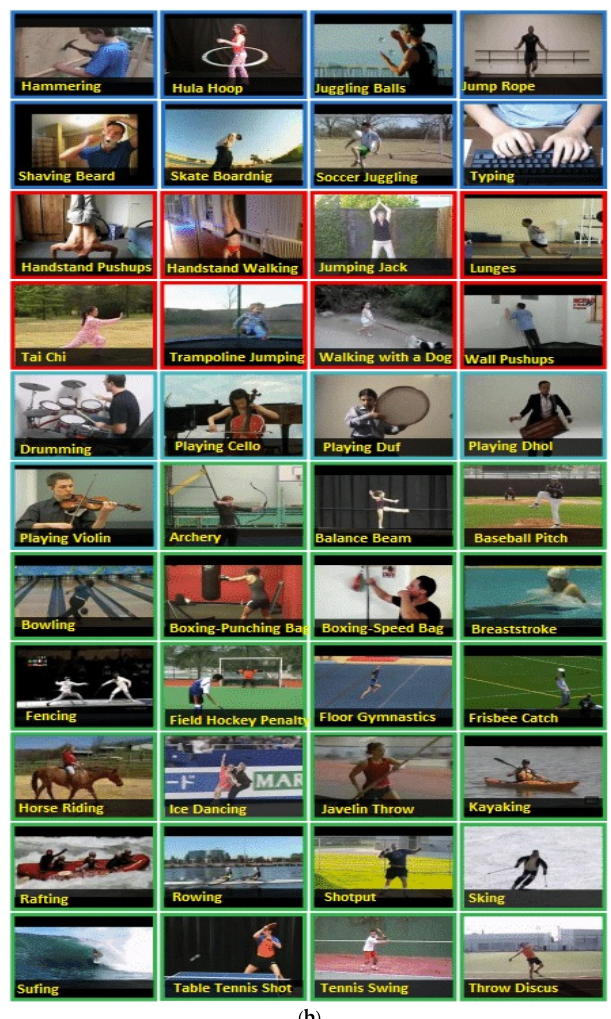
Figure 16. (a) Exemplar frames for actions 1–57 from UCF ‐ 101 dataset; ( b ) Exemplar frames for